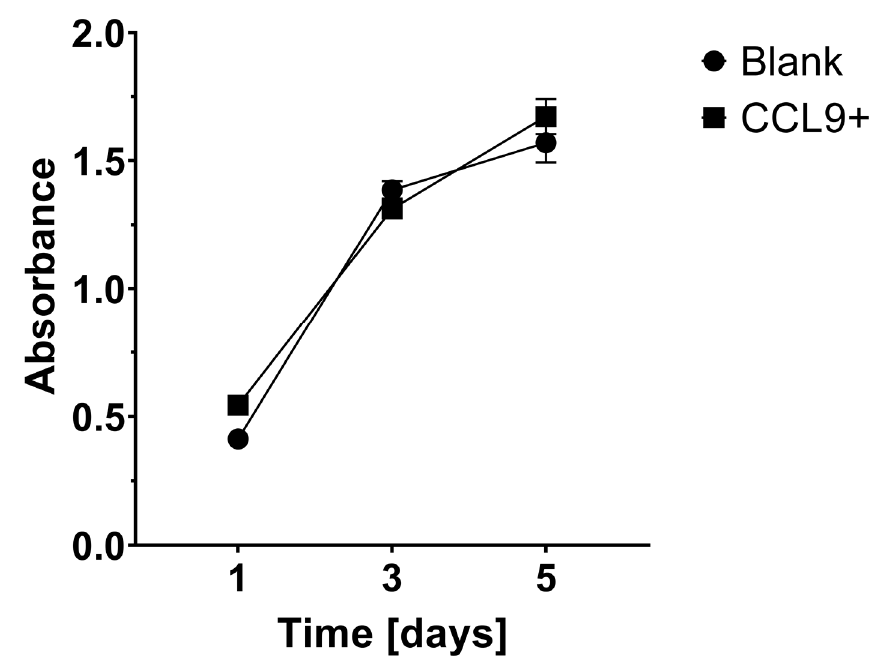
Figure 1. Cell proliferation rate assessed in the MTS test revealed no differences between blank control (CT26 cells carrying empty vector) or CCL9-overexpressing CT26 cells. Each experiment was performed in three replicates.